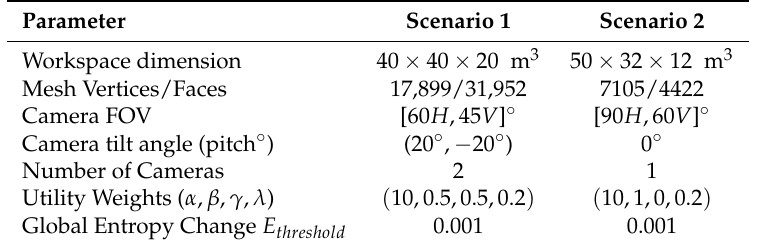
Table 1. The parameters of the Guided NBV used in the two simulation